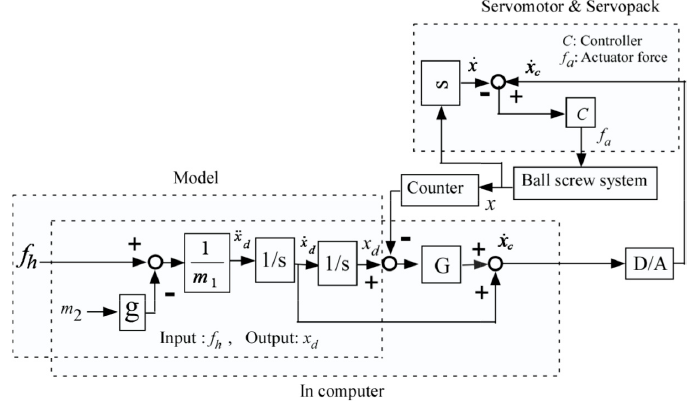
Figure 5. The block diagram of the feedback position control of the power assist robotic system. Here, G denotes the feedback gain, digital-to-analog (D/A) refers to the D/A converter, and x denotes the actual displacement. The feedback position control is implemented with the servomotor in the mode of velocity control.